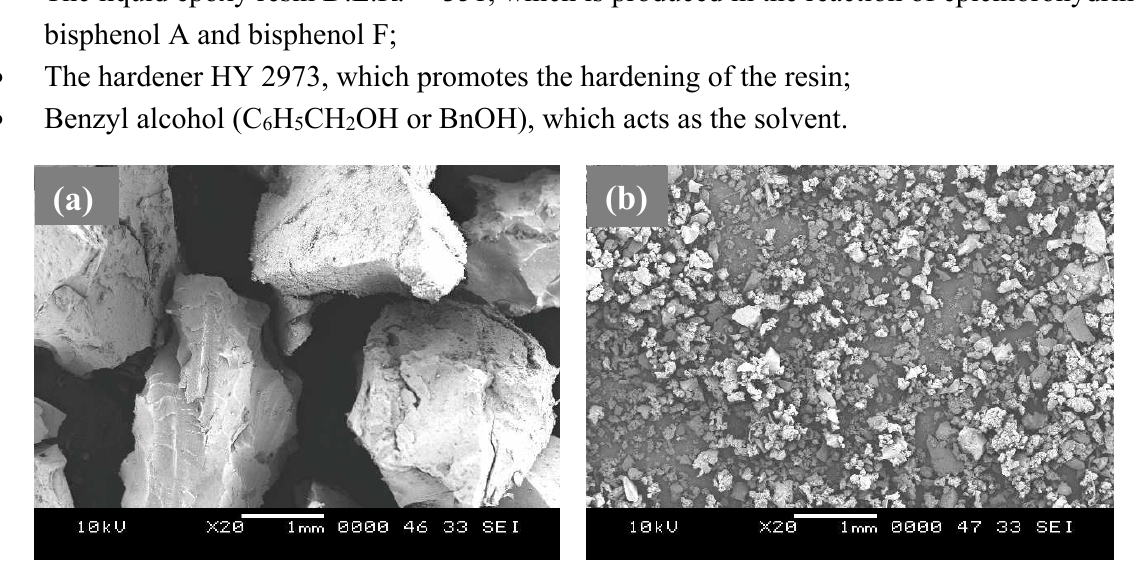
Figure 1. SEM images of crumb rubber (CR) particles. ( a ) Coarse- and ( b ) fine-type